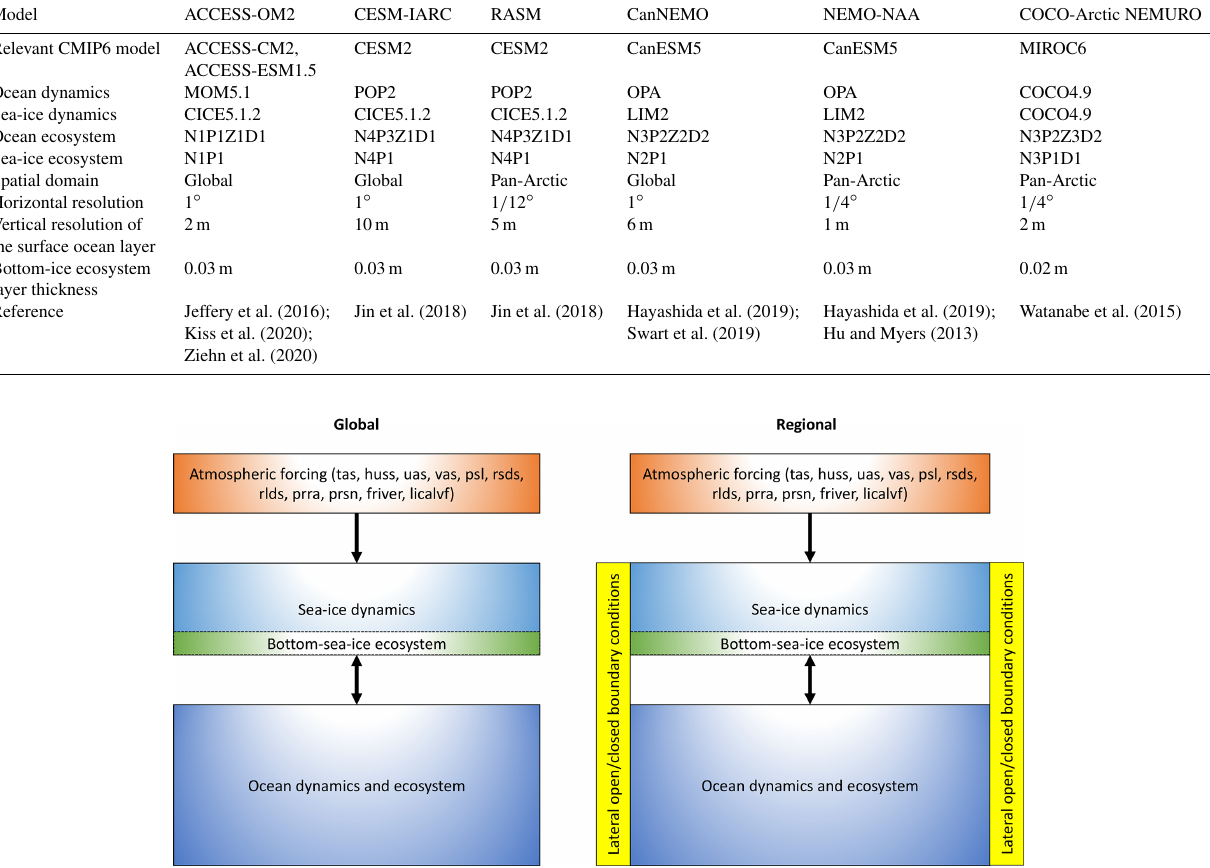
Figure 1. Global (left) and regional (right) configurations of the three-dimensional coupled sea-ice–ocean physical–biogeochemical mod- els participating in IAMIP2. The surface-atmospheric forcing dataset consists of air temperature at 10m (tas), specific humidity at 10m (huss), eastward wind at 10m (uas), northward wind at 10m (vas), sea level pressure (psl), downward shortwave radiation (rsds), downward longwave radiation (rlds), rainfall flux (prra), snowfall flux (prsn), river runoff (friver), and calving flux